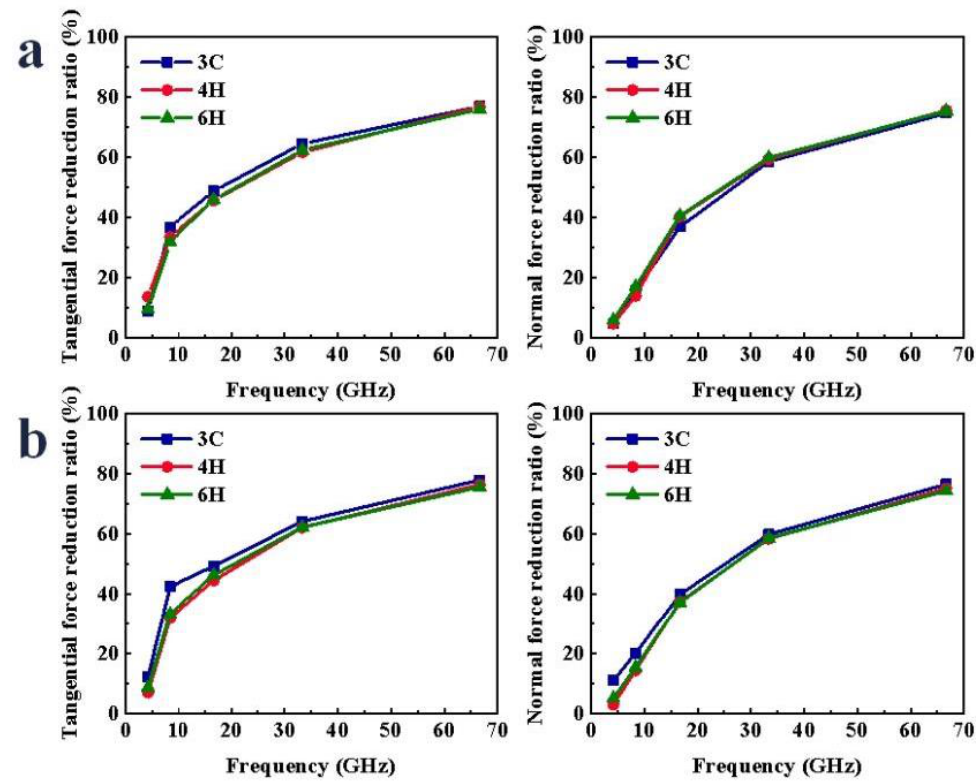
Figure 4. Variation in scratch force reduction ratio of SiC polytypes with different amplitudes: ( a ) Si-face and ( b ) C-face of SiC.